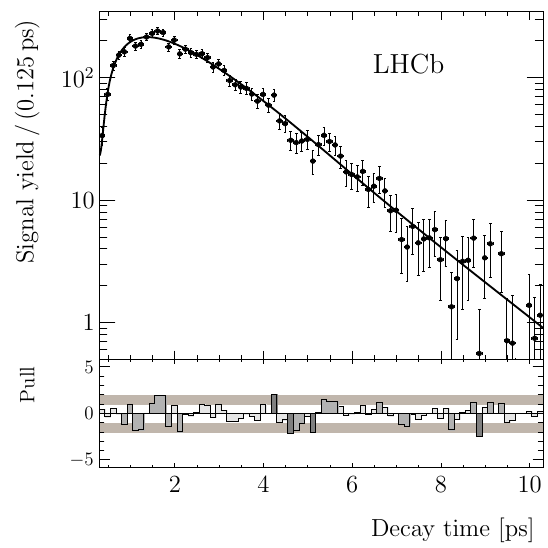
Figure 2 . Decay-time distribution of the B 0 D (cid:3)(cid:6) D (cid:7) signal candidates, summed over all data ! samples, where the background contribution is subtracted by means of the sPlot technique. The projection of the PDF is represented by the full line.